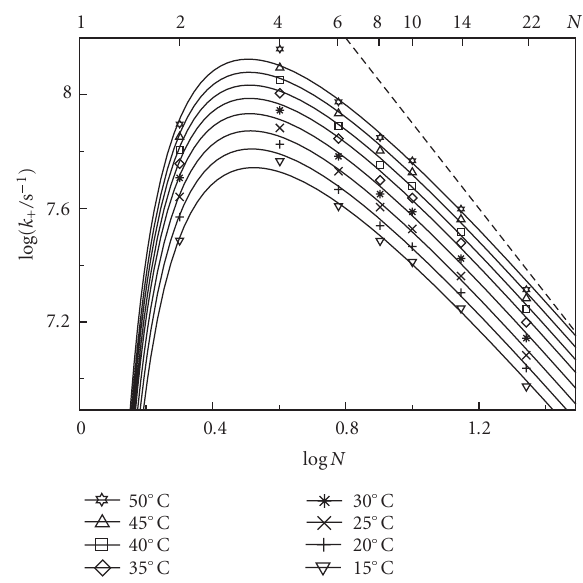
Figure 2: Double logarithmic plot of the looping rates ( k + ) at dif- ferent temperatures versus the peptide length, taken as the num- ber of intervening amide bonds ( N ). A simple function of the type y = a − 1 . 5 x − b/x was fitted to the experimental data to reflect the theoretical slope of − 1 . 5 at long chain lengths and the expected fallo ff ( b/x ) term at short chain lengths. The dashed line has a slope of − 1 . 5 and is shown to illustrate the deviation from theoretical be-